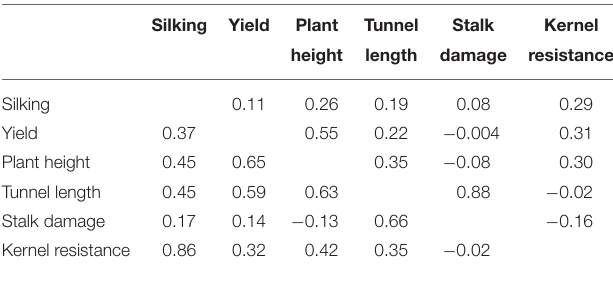
TABLE 2 | Genotypic (below) and phenotypic (above) correlation coefficients between agronomic and resistance to MCB traits recorded from RIL population derived from A637 × A509 evaluated in a 2 years experiment under MCB infestation.